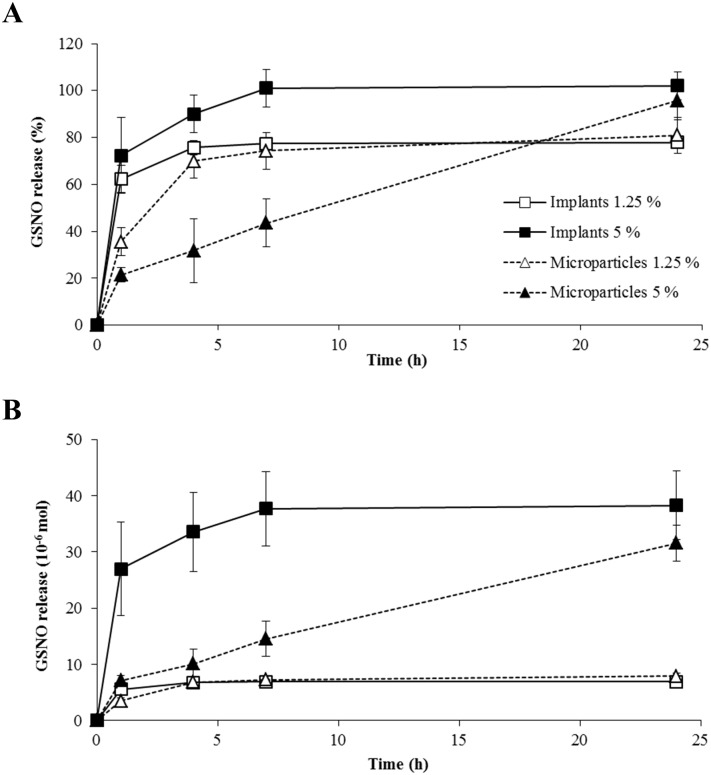

In vitro releases of GSNO from in situ forming implants and microparticles.GSNO loadings were 1.25% or 5% m/m (corresponding respectively to 7.5 mg/kg and 30 mg/kg of GSNO for in vivo experiments) based on the amount of polymer/GSNO/solvent solution. Panel A represents the release of GSNO expressed as % of the initial load; Panel B represents the release of GSNO in absolute values. Values are mean ± s.e.m. (n = 3).